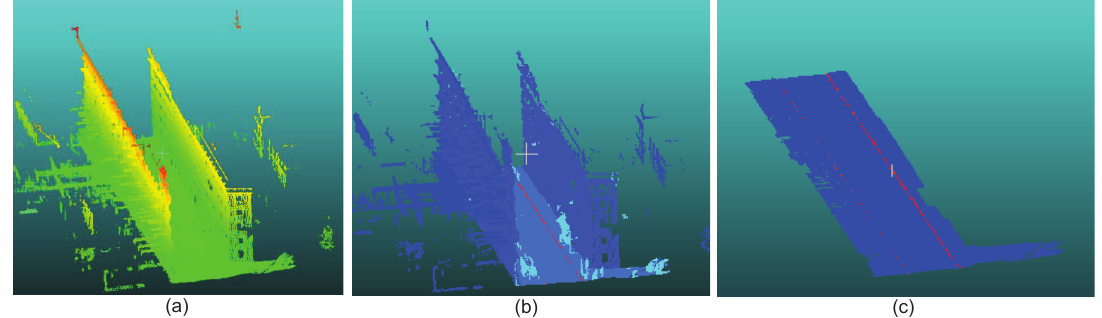
Figure 2: Dataset Urban ♯ 1 : (a) Example of 3D chunk containing N = 3 Mpts, acquired in Paris (France) over an approximative length of 82 m. For visualization purposes, the original point cloud is colored with respect to elevation values; (b) 3D object segmentation results: facades - dark blue, road and sidewalks - blue, non-ground objects - light blue, sidewalk borders and ramp access - red; (c) the extracted ground corresponding to road, sidewalks and ramp access: 1 . 27 Mpts.